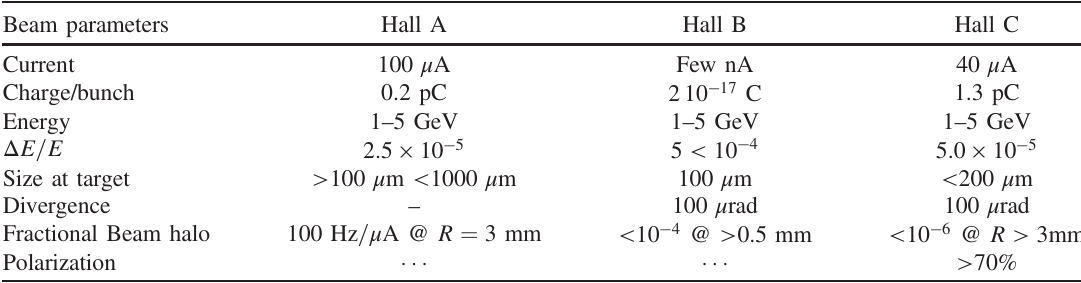
TABLE III. CEBAF experiment beam requirements 2004.